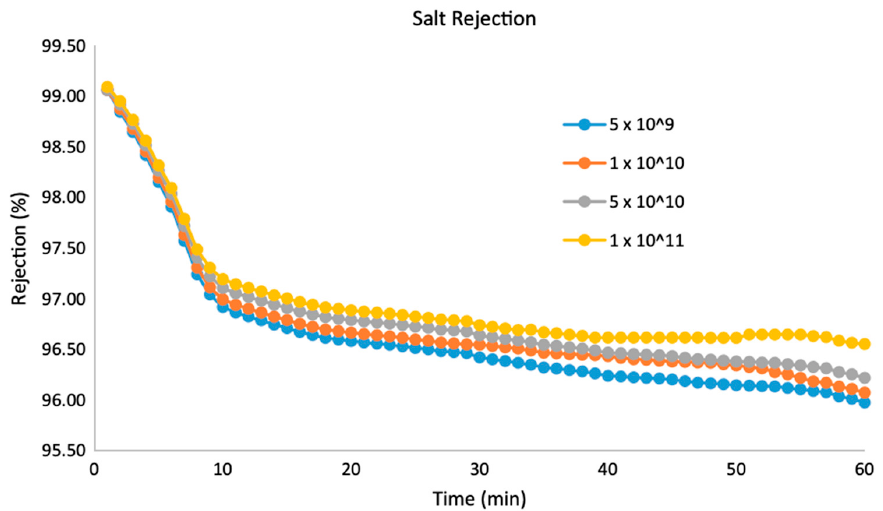
Figure 7. Salt rejection vs. time graph for different CNT densities of VA-CNT membranes (density is given in number of nanotubes/cm 2 )